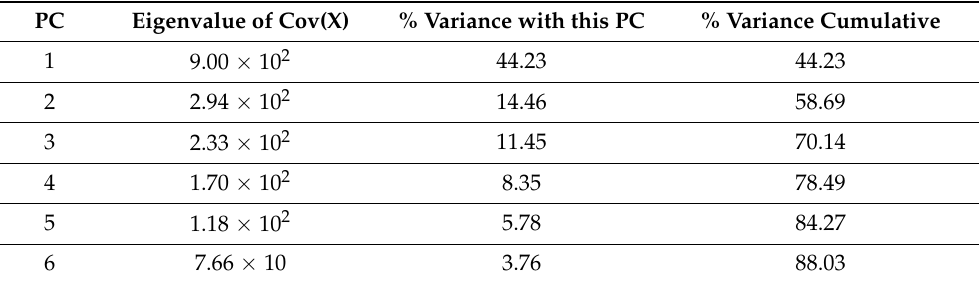
Figure A2. Mean spectra from each type of mining operation displaying variability of IR bands in the Si-OH stretching region (3200–3800 cm − 1 ) region and the fingerprint region (400–1500 cm − 1 ). Table A1. Table displaying eigenvalue, %variance captured and % cumulative variance captured for every PC.